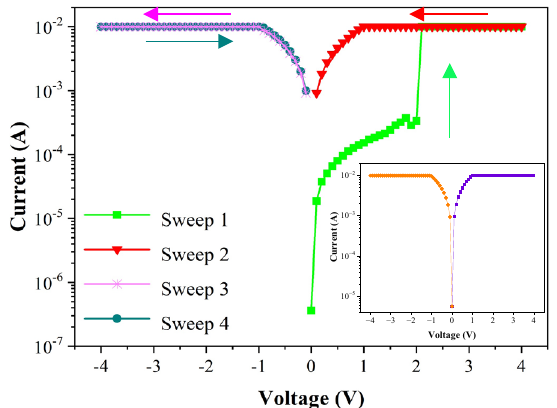
Figure 5. The I - V characteristic curves of the FTO/CsPbBr 3 /Al memory device. The illustration demonstrates that the device is always kept at a low resistance state during the subsequent scanning voltage.